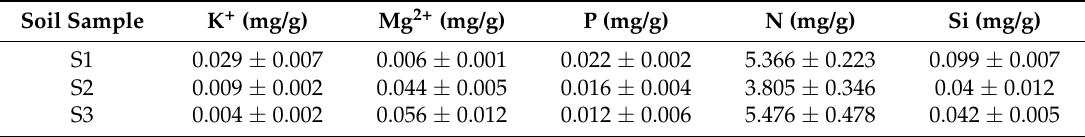
Table 1. Basic properties of the soil used in this study.